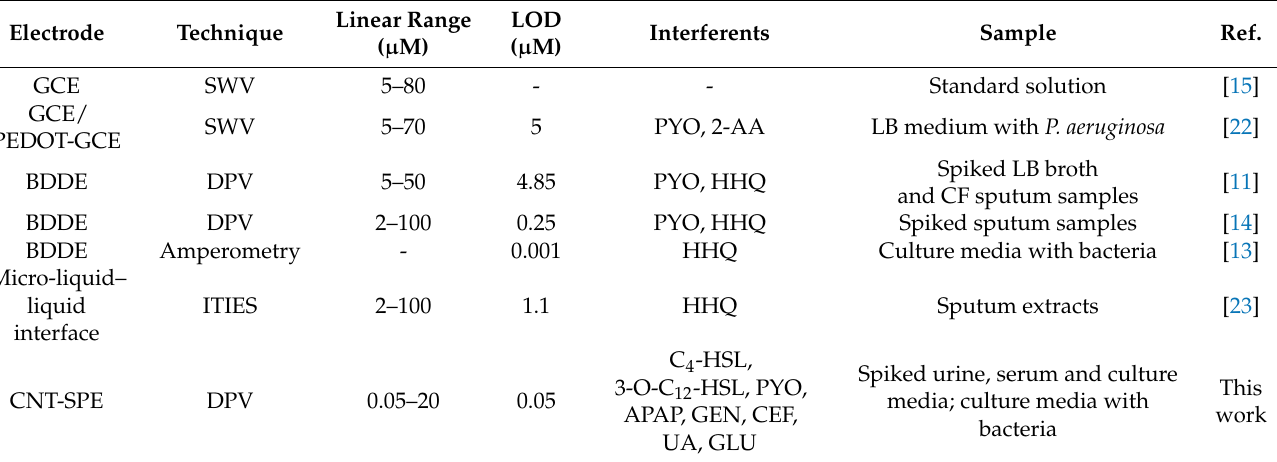
Table 3. Comparison of this sensor with other electrochemical methods previously reported for the detection of PQS.